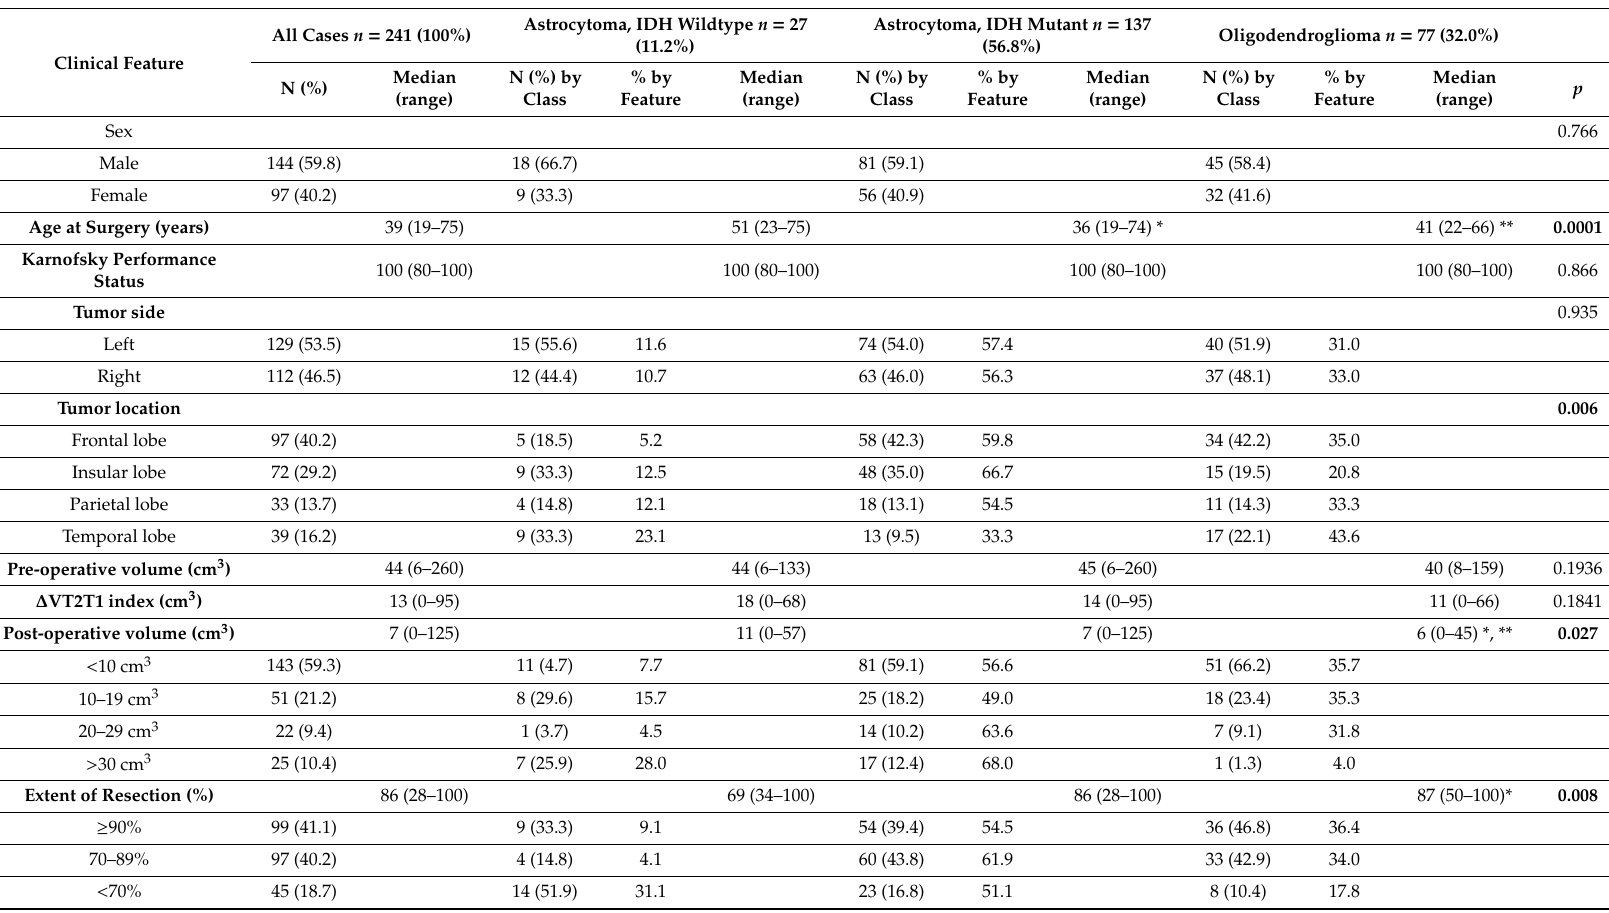
Table 1. Clinical and neuroradiological features of the 241 symptomatic LGG patients included in the study. For the features, tumor side, tumor location, post-operative volume, and extent of resection are reported both the %, within the molecular class, of the di ff erent feature subgroups, and the percentage of cases pertaining to each molecular class within each feature subgroups. * , ** p < 0.05 vs. astrocytoma, IDH wildtype and astrocytoma, IDH mutant, respectively. Boldfacing represents statistical significance ( p < 0.05) from Dunn’s